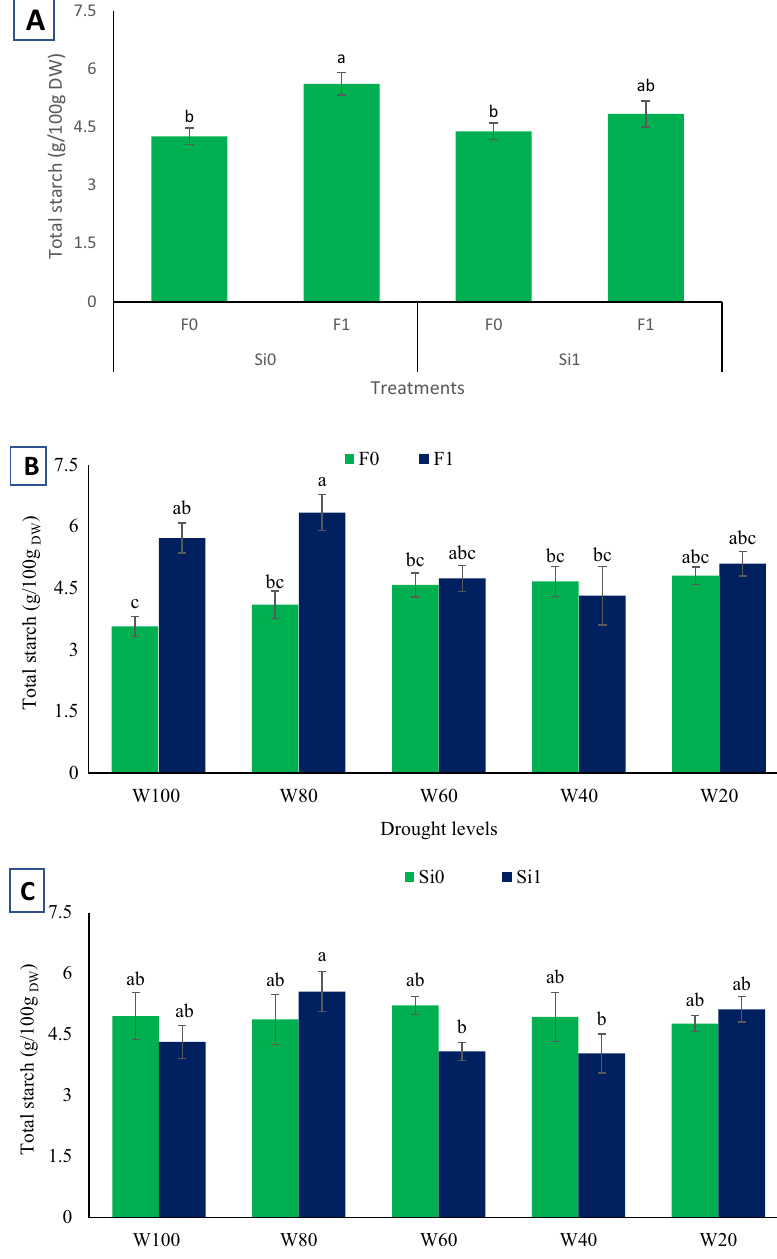
Figure 3. Total starch content variation among ( A ) Si application and fungi inoculation interactions, ( B ) various drought levels and fungi inoculation interactions and ( C ) various drought levels and Si application interactions in examined Licorice plants. According to the analysis of variance that only the multiple effects of fungi and Si showed significant difference, just its mean comparison is shown. Mean values with the same letters are not significantly different ( p < 0.05), Tukey test. W stands for water deficit treatment (5 levels including 100% (W100), 80% (W80), 60% (W60), 40% (W40), and 20% (W20) of field capacity), Si stands for silicon application (two levels including Si0 (no Si application) and Si1 (Si application)) and F stands for mycorrhiza inoculation (two levels including F0 (no inoculation) and F1